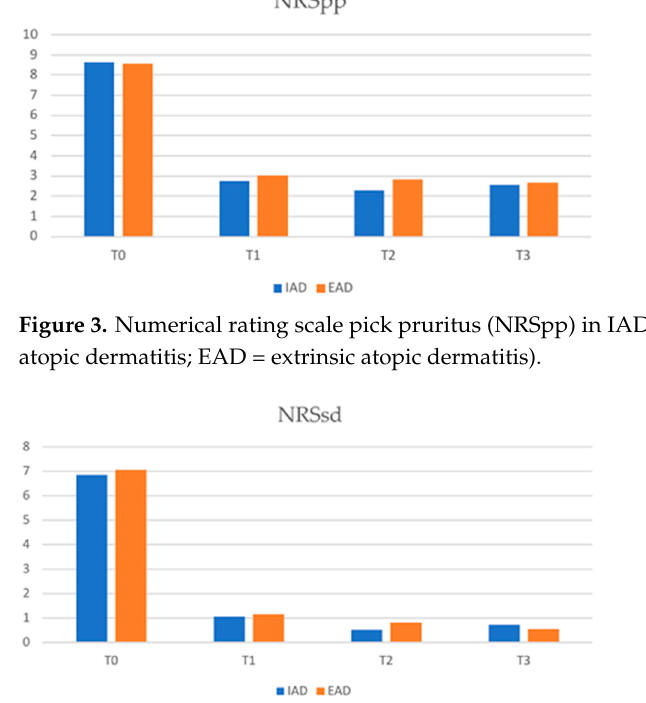
Figure 6. Mean eosinophils values (×10 9 /L) in IAD and EAD patients (IAD = intrinsic atopic dermatitis; EAD = extrinsic atopic dermatitis). With regard to mean LDH values, no statistically significant differences were found in the two groups at any timepoint. 4. Discussion We evaluated the possible difference between the H&N EASI in the two groups as this parameter appears to have an important impact in measuring quality of life compared to other body area EASIs [14]. In contrast to what has previously been shown by other studies [5,9], our patients with EAD had a higher mean H&N EASI than patients with IAD at the baseline. During treatment with dupilumab, these values remained higher in the EAD group, although without a statistically significant difference and with an irregular trend, probably due to red face events. The mean EASI values were significantly higher in patients with EAD at T0 as well as at T1 and T2; only at T3, after 48 weeks of treatment, was this difference no longer significant. Therefore, patients with EAD in our sample show a higher disease burden at the baseline that remains higher than patients with IAD in the first 32 weeks of dupilumab treatment. Nevertheless, the percentage of patients achieving an EASI75 is high in both the IAD and EAD groups (61% vs. 50% at T1, 66% vs. 60% at T2, and 53% vs. 65% at T3),